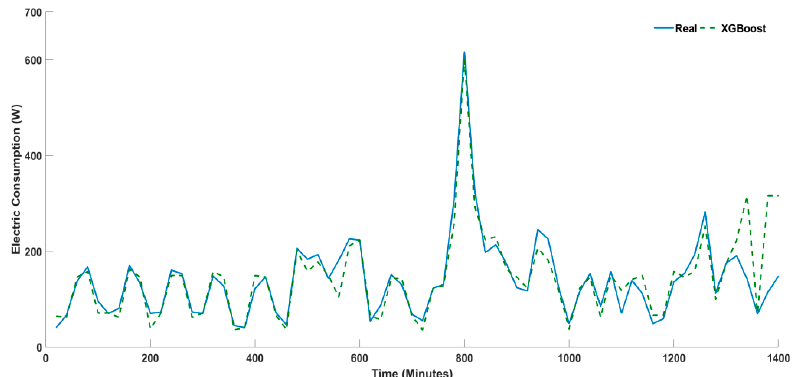
Figure 6. XGBOOST for univariate time series.